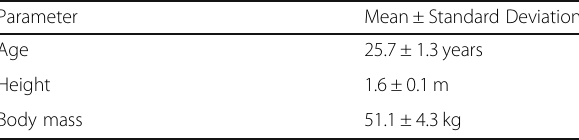
Table 1 Demographic data of the participants ( N = 7)